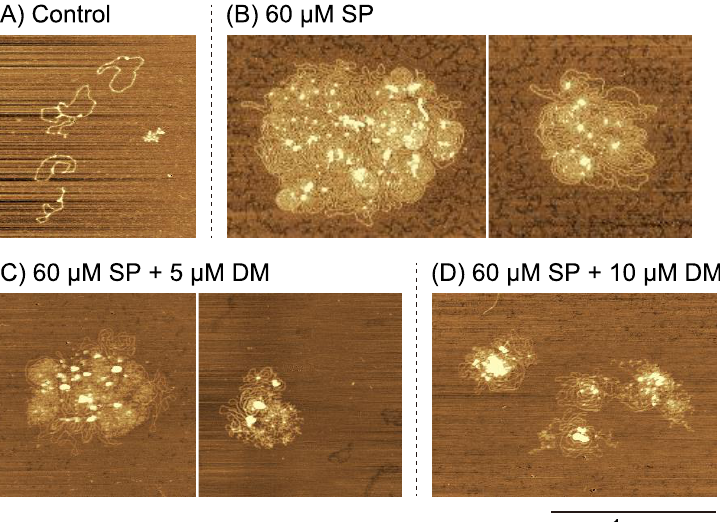
Figure 3. Atomic force microscopy images of plasmid DNA. Plasmid DNA (4331 bp) in the presence of various concentrations of spermine (SP) and daunomycin (DM): ( A ) control (6 µM SP), ( B ) 60 µM SP, ( C ) 60 µM SP and 5 µM DM and ( D ) 60 µM SP and 10 µM DM. The DNA concentration was fixed at 0.6 µM in nucleotide unit. The scale bar is 1 µm and applies to all subfigures.